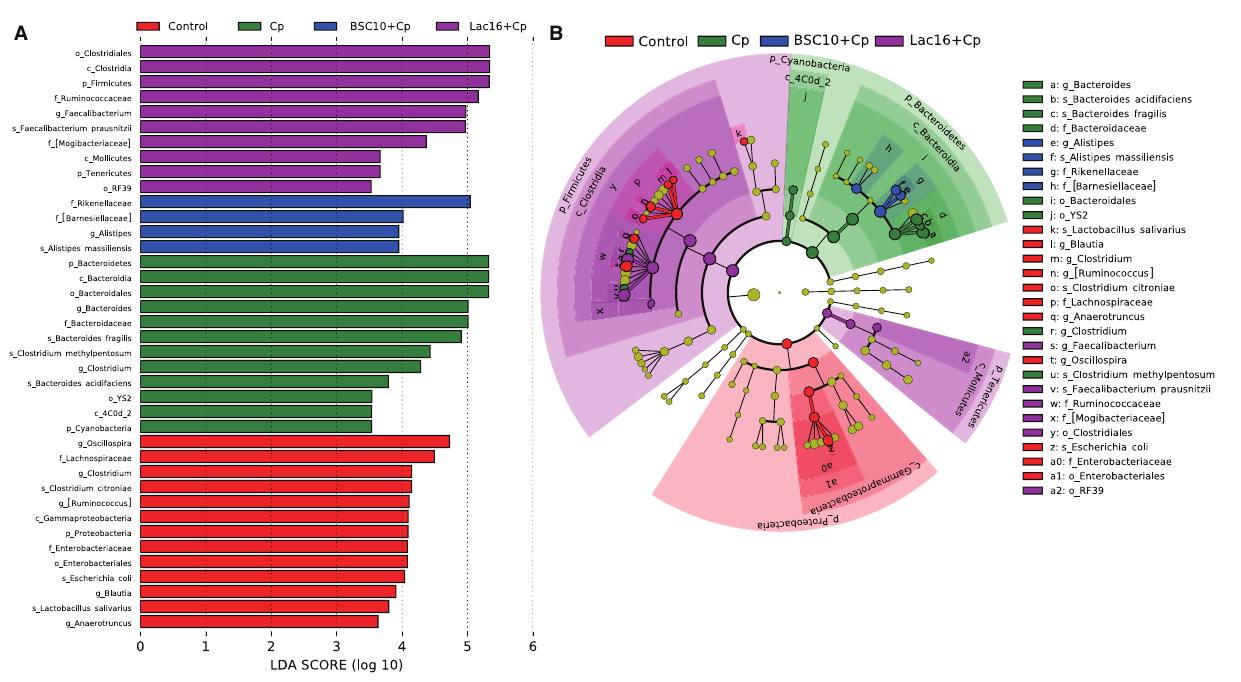
FIGURE 4 | Linear discriminant analysis (LDA) effect size (LEfSe) analysis (LDA > 3., p < 0.05) of the intestinal microbes. Histogram (A) and cladogram (B) of LEfSe analysis among the four groups. The prefixes “p_,” “c_,” “o_,” “f_,” “g_,” and “s_” represent the annotated levels of phylum, class, order, family, genus, and species.